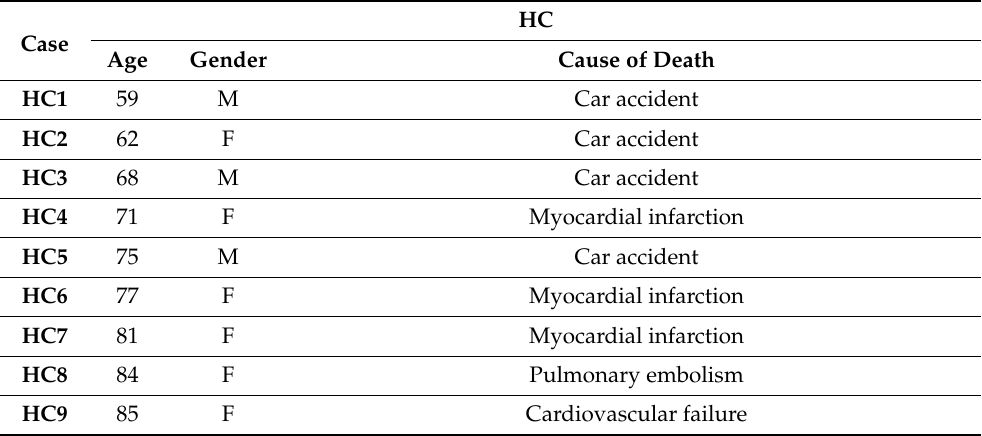
Table 1. Demographic data of control and AD